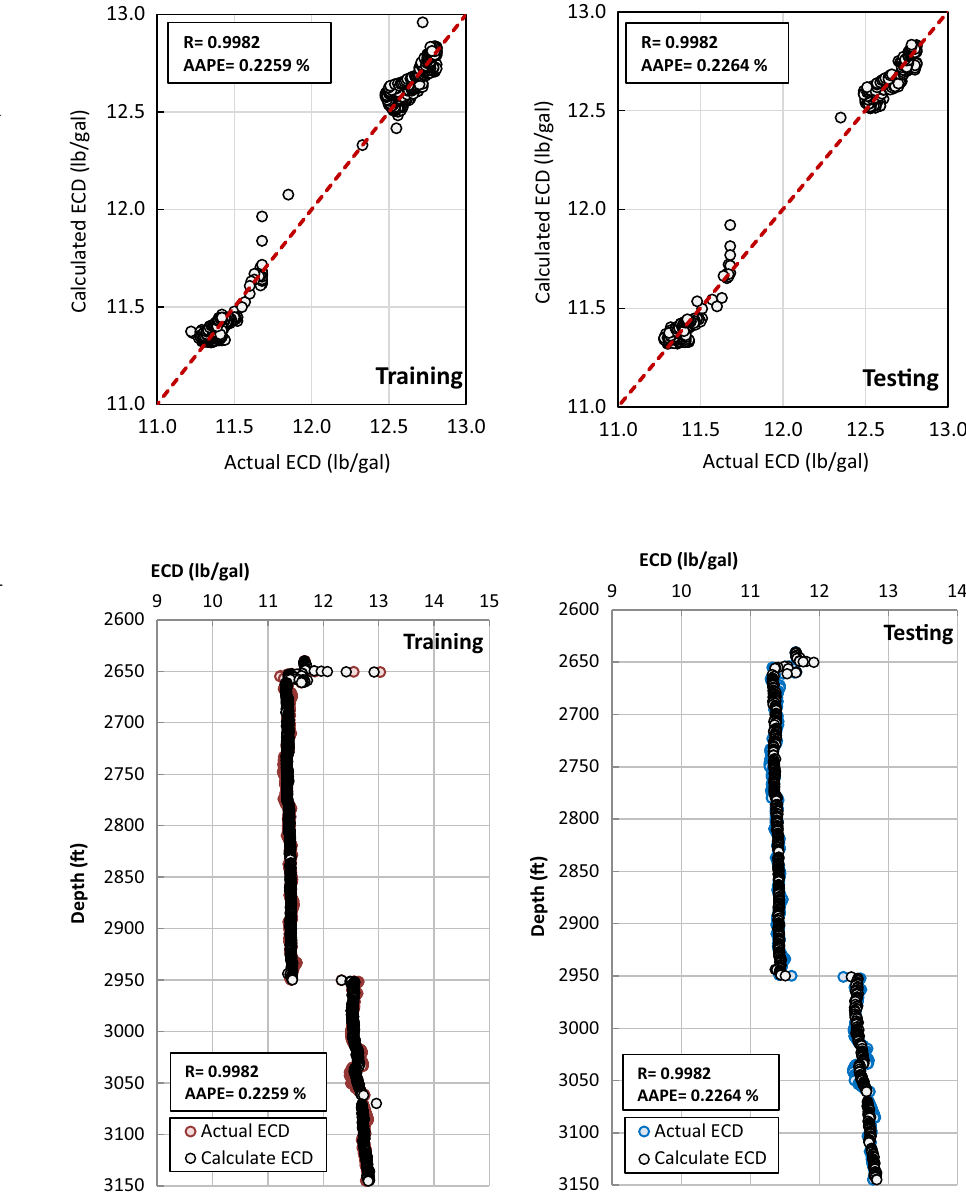
layer neurons (Table 3), b 1 neurons and input layer, w 2 neurons and the output layer neuron representing ECD, and b is the bias of the hidden layer N and the output layer 2 ( b = − 0.291). 2